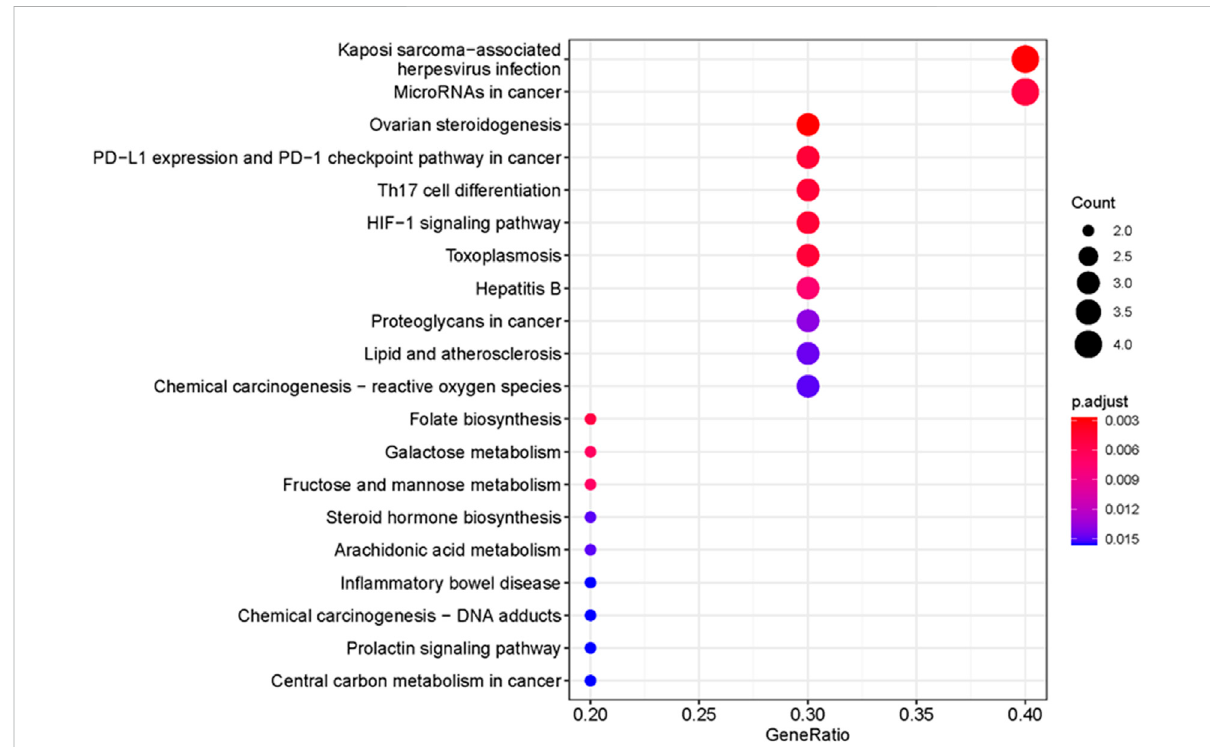
FIGURE 7 KEGG signaling pathway enrichment of FFXST in the treatment of IS. The larger the size of the dot, the more the genes are annotated in the entry, and the redder the color of the dot, the lower the q